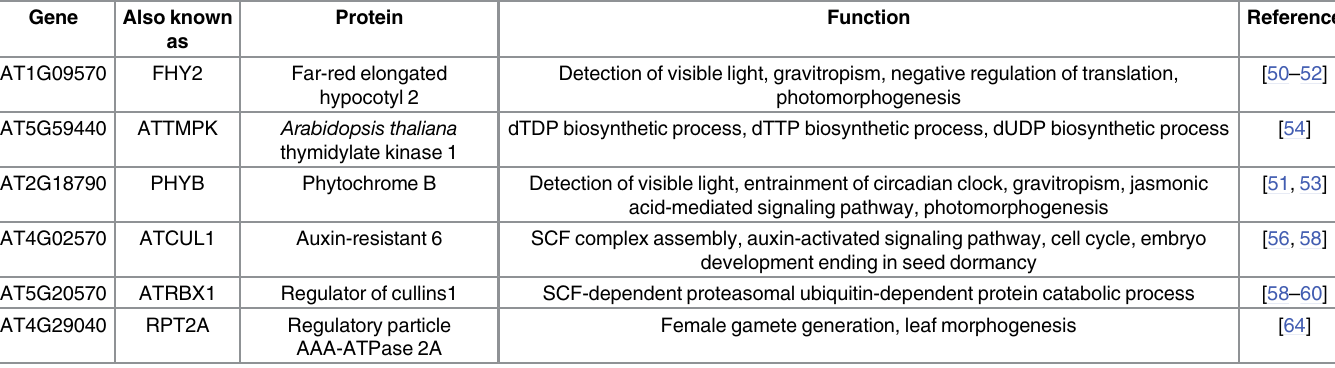
Table 2. Six candidate genes identified by the shortest-path-based